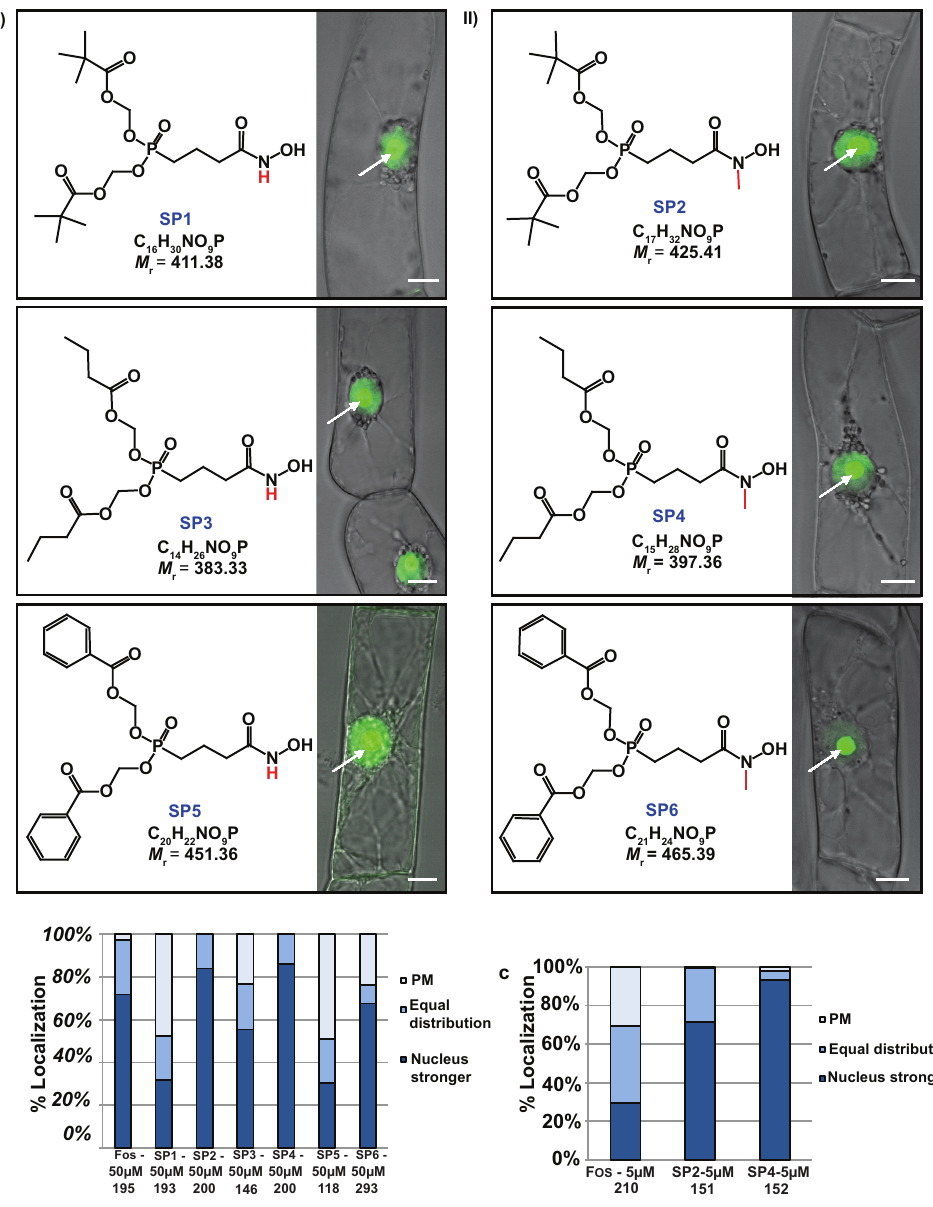
Figure 6. a) Confocal microscopy images showing the subcellular localization of H -GFP-DB-CVIL fusion protein after treatment 6 with a series of prodrug molecules (SP1–SP6) derived from Fos, an effective inhibitor of DXR. Six molecules have been tested in total. The tested molecules can be divided into two groups. I) Three non-methylesterprodrugs (derived from LK1: SP1, SP3 and SP5). II) Three molecules with a methyl group bound to the N-atom (derived from LK2: SP2, SP4 and SP6). The respective phosphonate groups were masked as acyloxymethyl phosphonate esters 79 . Cells were pre-treated for 3 h with 50µM of each inhibitor (solvent: methanol) before expression of H -GFP-DB-CVIL was induced by addition of dexamethasone (10µM final concentration). At the chosen concentration, the majority of all 6 treated cells showed partial or very dominant delocalization of the fluorescence from the plasma membrane to the nucleus/nucleolus. The images are overlays from pictures in transmission light and fluorescence mode and were acquired as described in the main text. Bars = 10µm. b) Statistical approach to compare the impact of six different pro-drugs on the in vivo localization of the prenylable fusion protein H -GFP-BD-CVIL. The cells (> 100) were treated with 50µM of the respective inhibitor. Cells were counted by view and sorted in three 6 main categories (dominantly membrane localized (PM), nucleus localized and intermediate localization). The number of cells analyzed in each condition is indicated. c) Statistical approach to compare the impact of six different pro-drugs on the in vivo localization of the prenylable fusion protein H -GFP-BD-CVIL. The cells were treated with 5µM of the respective inhibitor. Cells (> 100) were counted by view 6 and sorted in three main categories as described